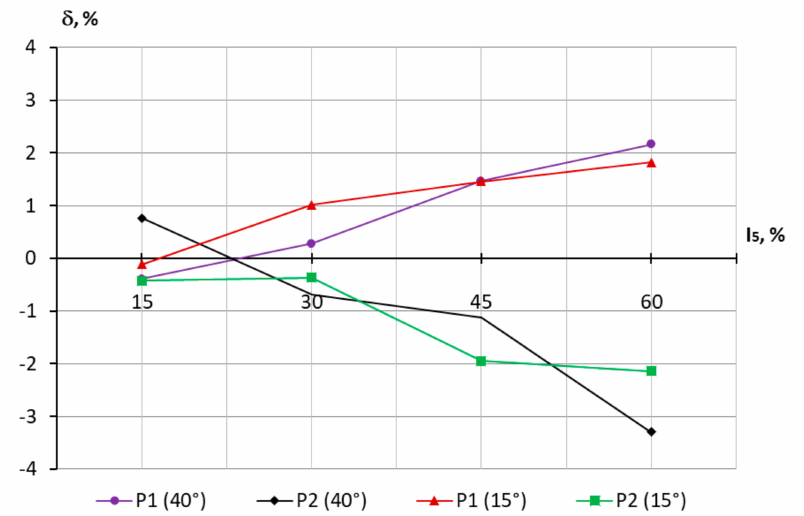
Figure 4. The dependences of the relative metering error for active power on the amplitude of the 5th harmonic current at di ff erent values of the phase shift angle at the fundamental